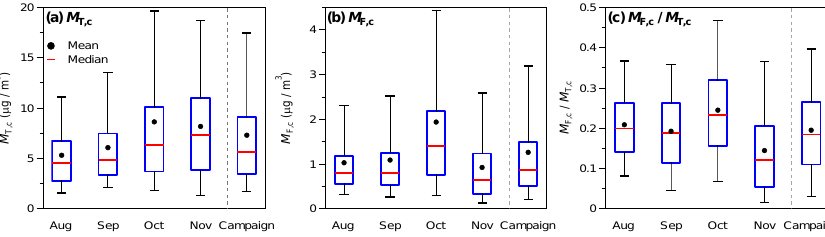
Fig. 5. Statistical distribution of integrated coarse TAP and FBAP mass concentrations (1–20µm) measured during each month (Aug–Nov) and over the full campaign as box-whisker plots (plots analogous to Fig. 2): (a) M T , c , (b) M F , c , (c) M F , c / M T , c .